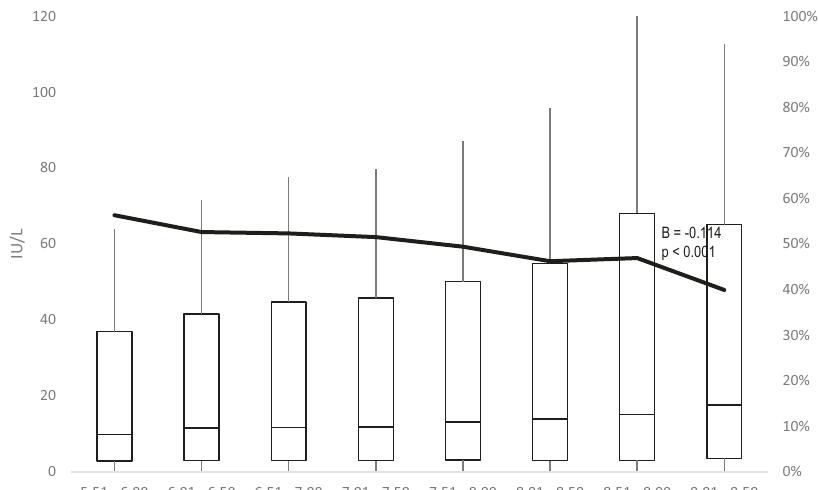
Fig. 2 Long-term anti-HBs titre (boxplot, left y axis) and proportion of individuals below 10 IU/l (black line, right y axis) by time interval (months) between the administration of the second and the third dose in the Cohort 1.